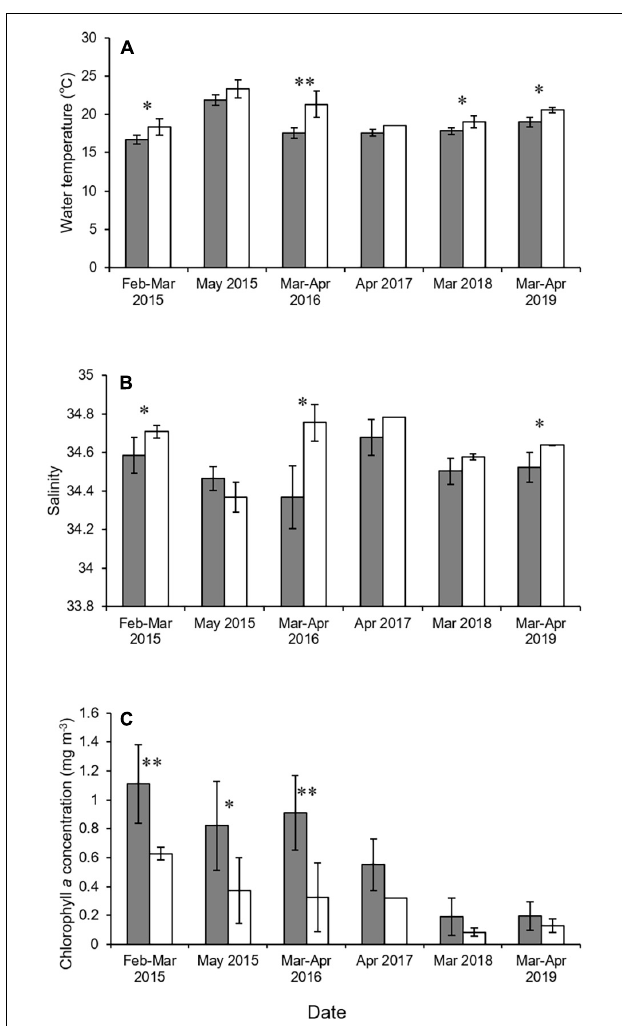
FIGURE 2 | Mean water temperature (A) , salinity (B) , and chlorophyll a concentration (C) in the mouth of Kagoshima Bay and the Osumi Strait. Black and white bars indicate the mouth of Kagoshima Bay and the Osumi Strait, respectively. Bars indicate standard deviation. The asterisks ∗ and ∗∗ indicate significant levels of P < 0.05 and P < 0.01.